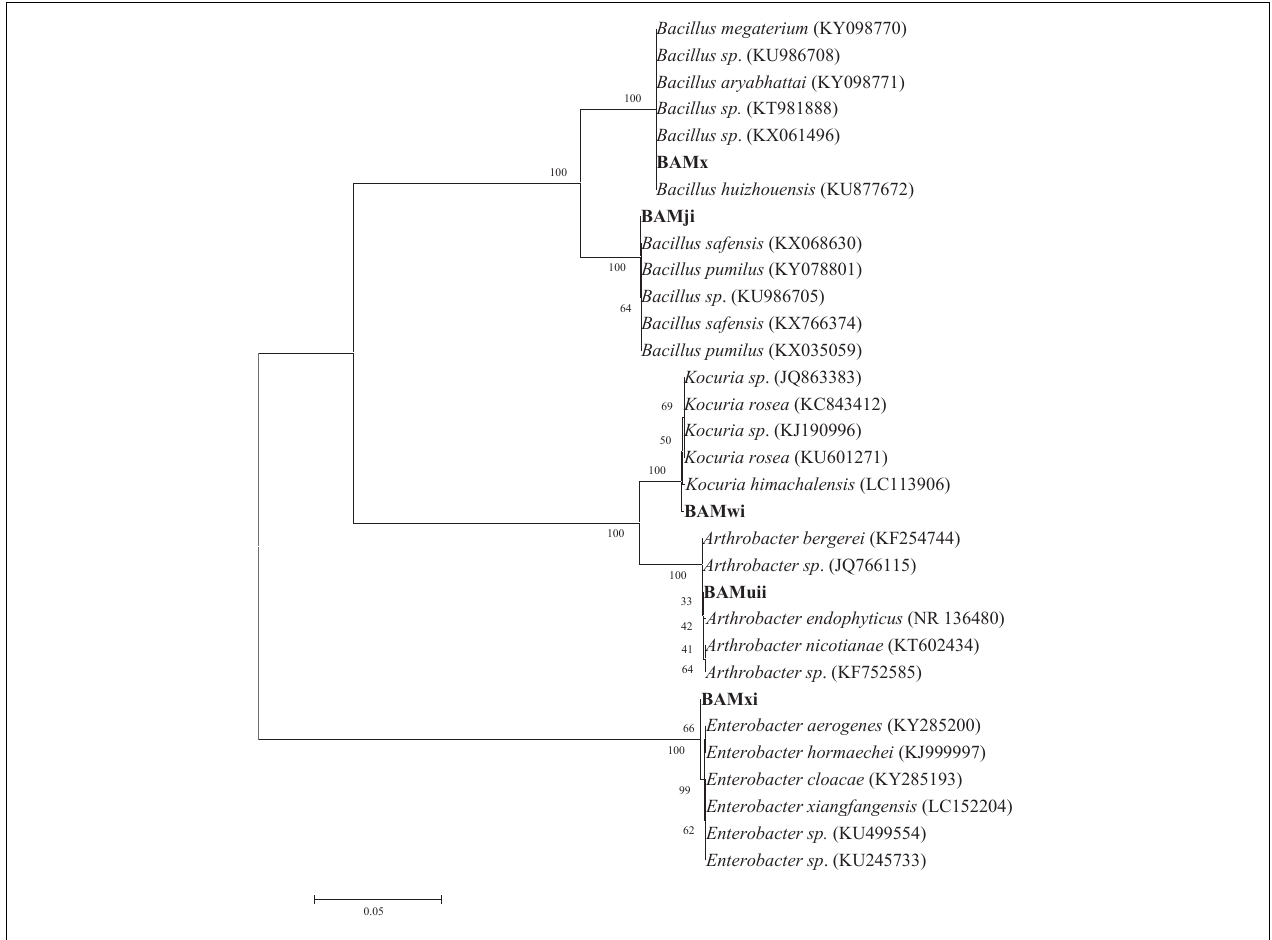
FIGURE 12 | The phylogenetic tree based on 16S rRNA sequences using the neighbor-joining method for bacterial isolates and their closely related type strains. TABLE 4 | Results of 16S rDNA gene sequence similarities of rhizobacteria isolates and GenBank accession numbers using BLASTn algorithm isolate code. Isolate